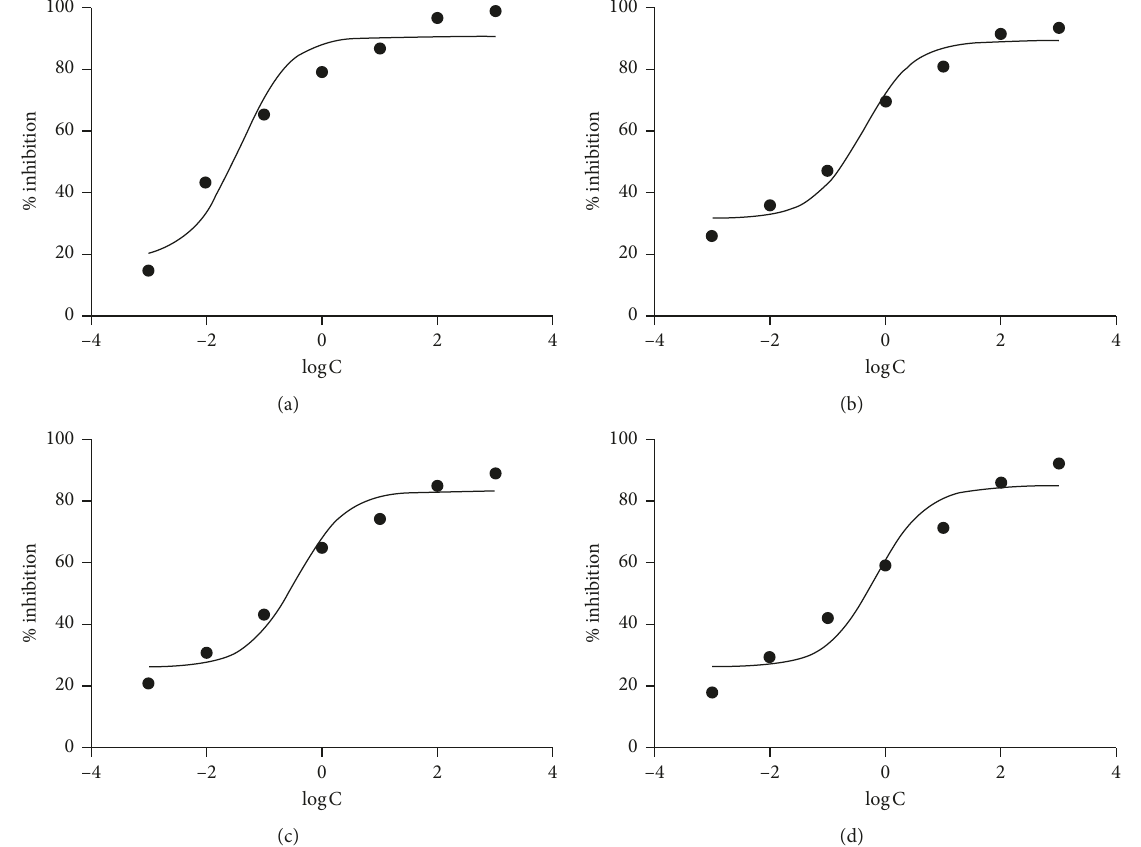
Figure 2: IC 50 ( μ M) of the selected compounds ( 4a , 4b , and 4c ) and control drugs against MAO-B enzyme. (a) Selegiline (0.038 μ M); (b) 4a (0.42 μ M); (c) 4b (0.36 μ M); (d) 4c (0.69 μ